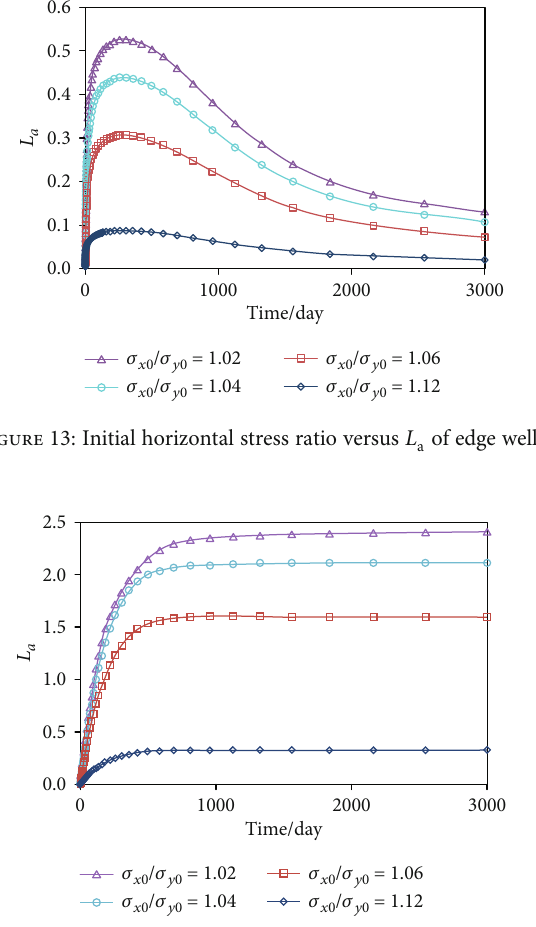
of the middle a